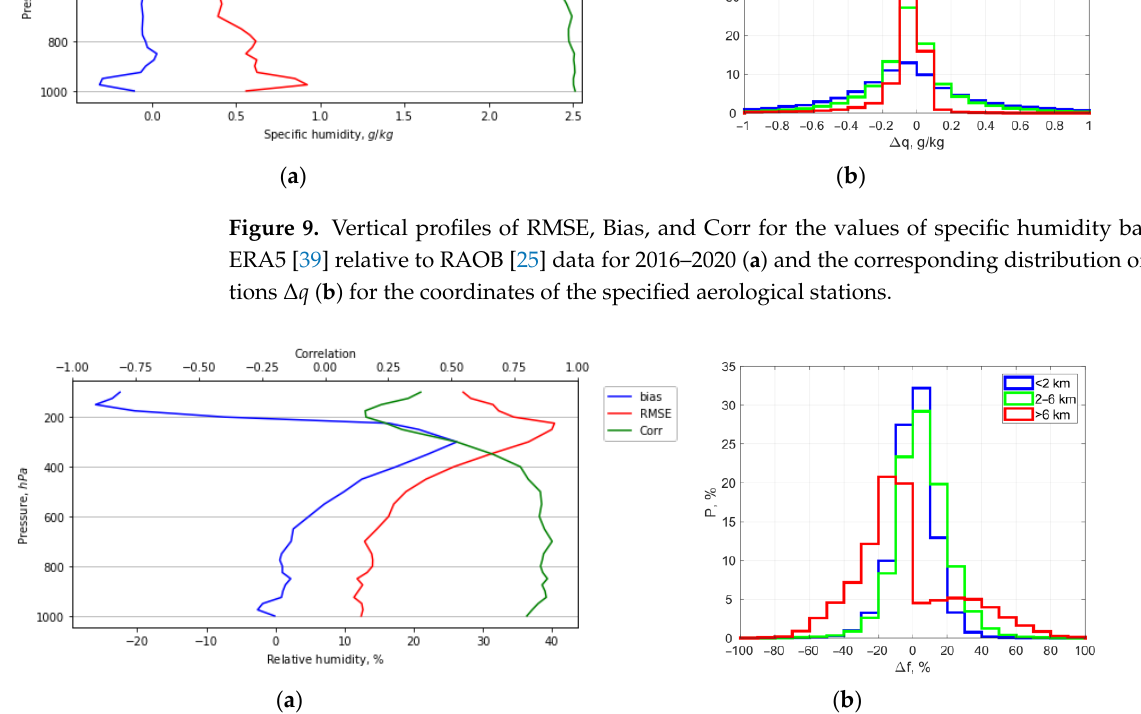
Figure 10. Vertical profiles of RMSE, Bias, and Corr for the values of relative humidity based on ERA5 [39] relative to RAOB [25] data for 2016–2020 ( a ) and the corresponding distribution of deviations Δ f ( b ) for the coordinates of the specified aerological stations.